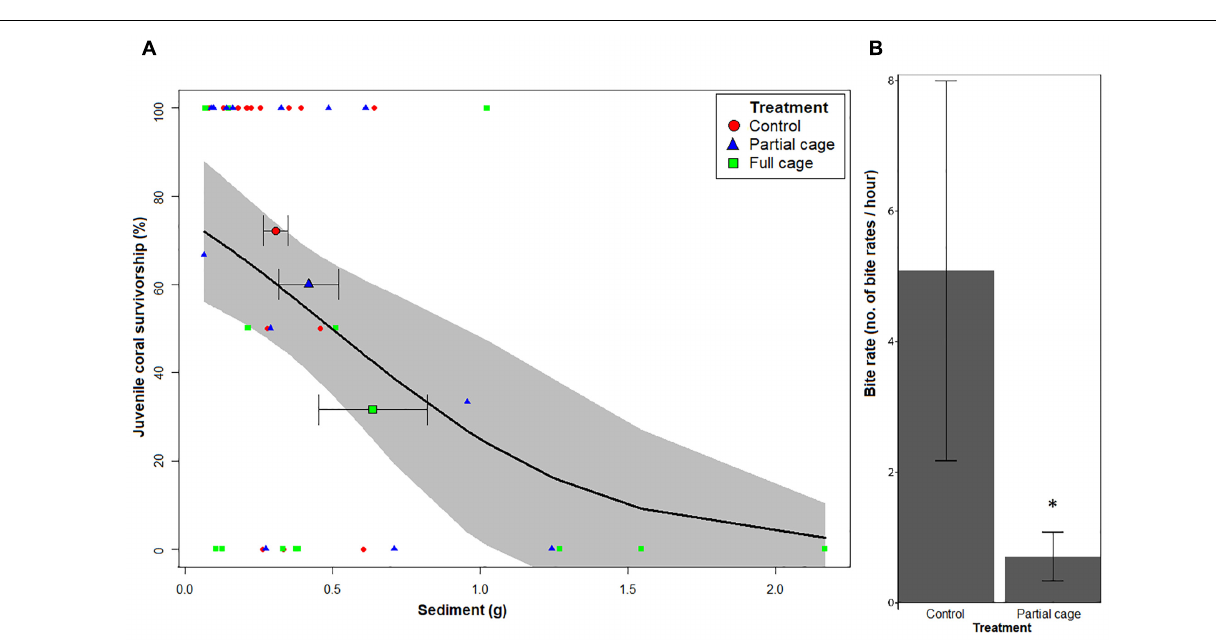
FIGURE 4 | (A) Survivorship of juvenile corals against dry sediment mass in the fitted generalized linear model. Bold line and shaded region represent the fitted generalized linear model and its 95% confidence interval (CI). Red circles, blue triangles and green squares represent the raw sediment mass and coral survivorship on each tile according to control, partial cage and full cage treatments, respectively. Enlarged bold points for each treatment represent the mean survivorship treatment and sediment mass. Horizontal error bars represent standard errors ( ± SE) for corresponding mean sediment mass. The symbol ‘ ∗ ’ denotes variable showing a significant association to coral survivorship at α = 0.05 in the model. (B) Mean bite rates across caging treatment levels. The symbol ‘ ∗ ’ denotes significant differences in bite rates in partial cages in comparison to control tiles (Mann–Whitney- U -test; p -value < 0.05). Error bars are ±